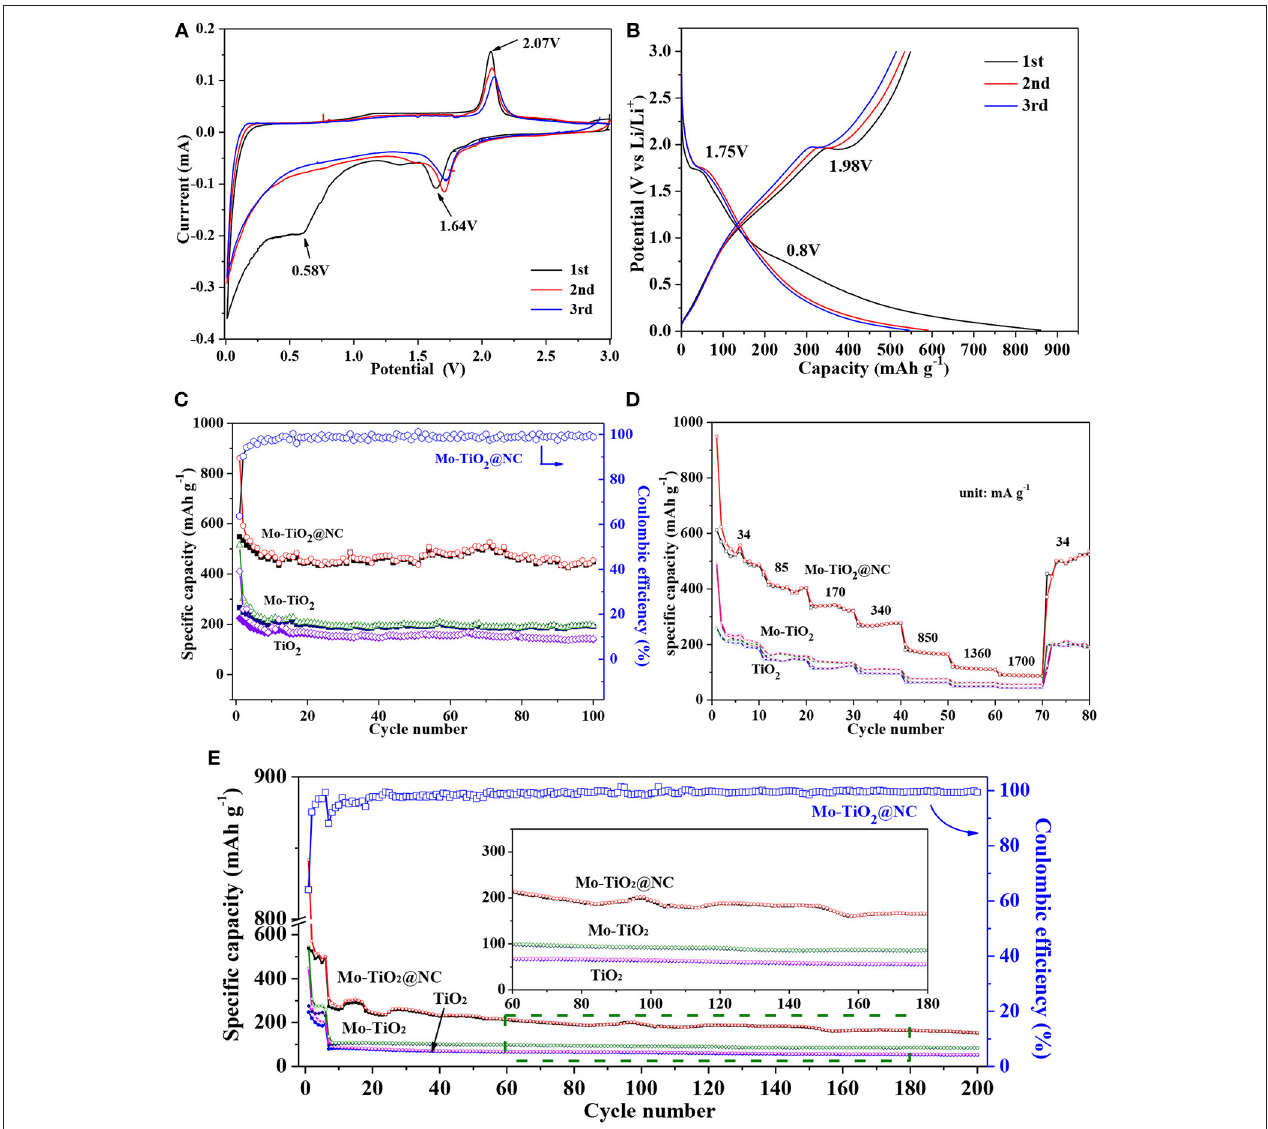
FIGURE 4 | (A) Cyclic voltammograms (CV) curves of the first three cycles of Mo-TiO 2 @NC. (B) The 1st, 2nd, and 3rd voltages-capacity curves of Mo-TiO 2 @NC at a current density of 34mA g − 1 . (C) Cycle performance of TiO 2 , Mo-TiO 2 , and Mo-TiO 2 @NC at a current density of 34mA g − 1 . (D) Rate performances of TiO 2 , Mo-TiO 2 , and Mo-TiO 2 @NC electrodes from 34 to 1,700mA g − 1 . (E) Cycle performance of TiO 2 , Mo-TiO 2 , and Mo-TiO 2 @NC at a current density of 850mA g − 1